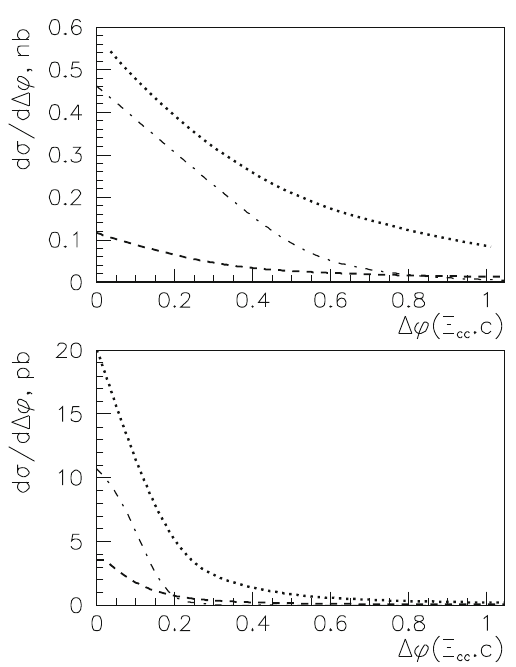
Fig. 2 The process g + g → Ξ cc + ¯ c + ¯ c ; azimuthal angle difference between the Ξ cc baryon and the comoving ¯ c -quark as seen under the different kinematic constraints. Upper panel: dotted, p Ξ T > 5 GeV, > 20 GeV; dashed, p Ξ > 20 GeV, p ∗ > 20 GeV; dash-dotted, p ∗ T T T > 50 GeV; m ∗ < E ∗ / 3. Lower panel: dotted, p Ξ T > 20 GeV, p ∗ T > 50 GeV; dash-dotted, m ∗ < E ∗ / 10 dashed, p Ξ T > 50 GeV, p ∗ T